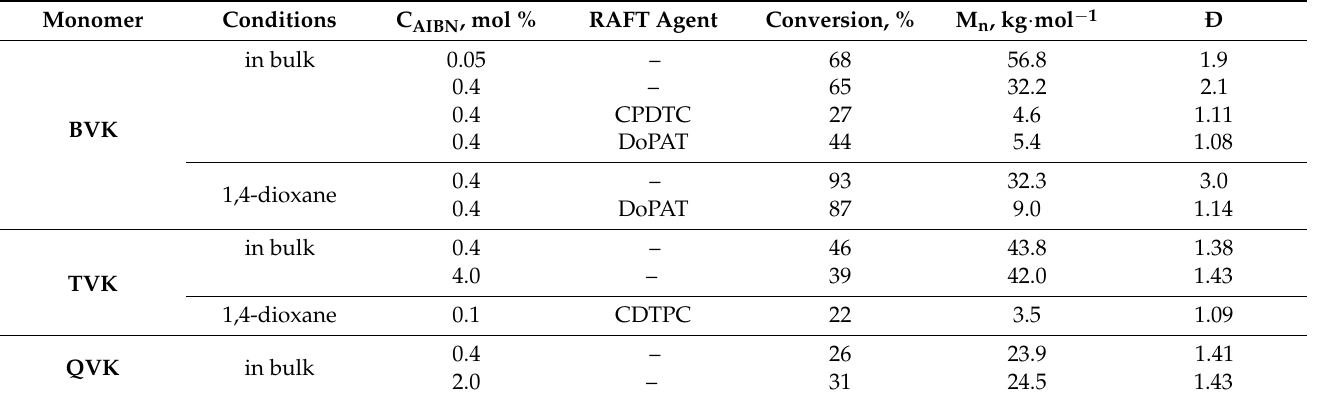
Figure 9. SEC curves of ( a ) poly(BVK) formed in bulk conventional radical (1, 2) and RAFT (3, 4) polymerization at C AIBN = 0.05 (1) and 0.4 mol % (2–4), CPDTC (3), and DoPAT (4); ( b ) poly(BVK) (2) and poly(TVK) (1, 3) formed in solution conventional radical (1) and RAFT (2, 3) polymerization at C AIBN = 0.1 (3) and 0.4 mol % (1, 2), DoPAT (2), and CPDTC (3). [RAFT]/[AIBN] = 10, T = 80 °C . Table 2. Molecular weight characteristics of polyvinyl ketones formed in conventional radical and RAFT polymerization at 80 °C and [RAFT]/[AIBN] = 10.